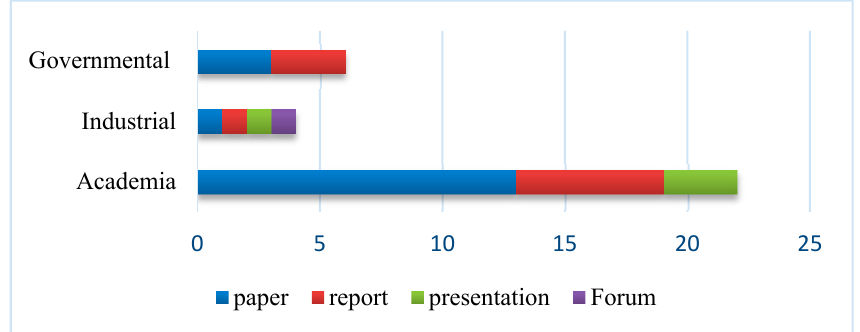
Figure 3. Literature overview: the number of literature types for different organizations.